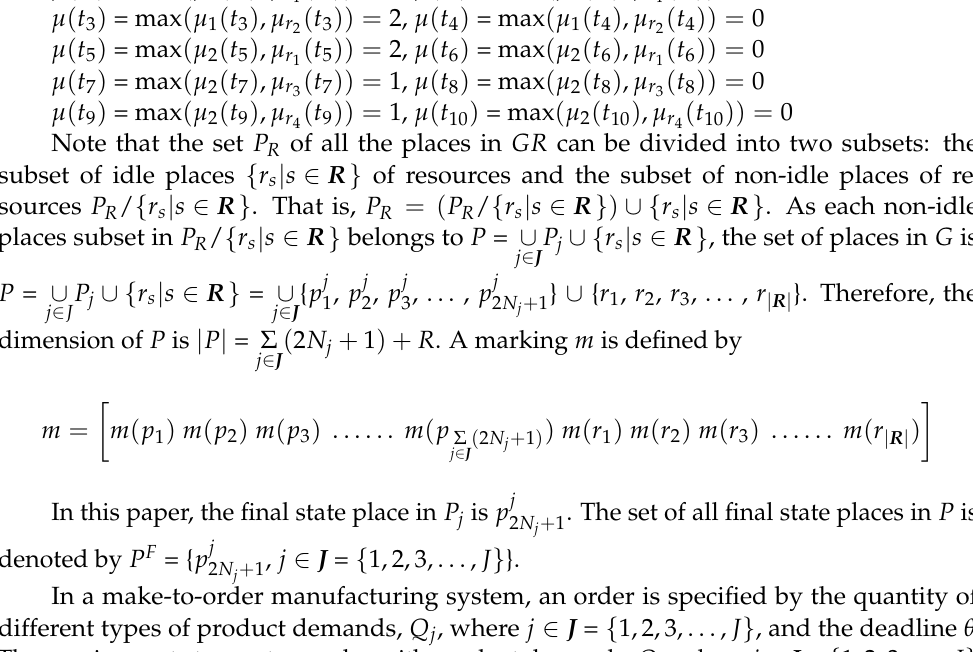
Figure 3. The model of two processes G .